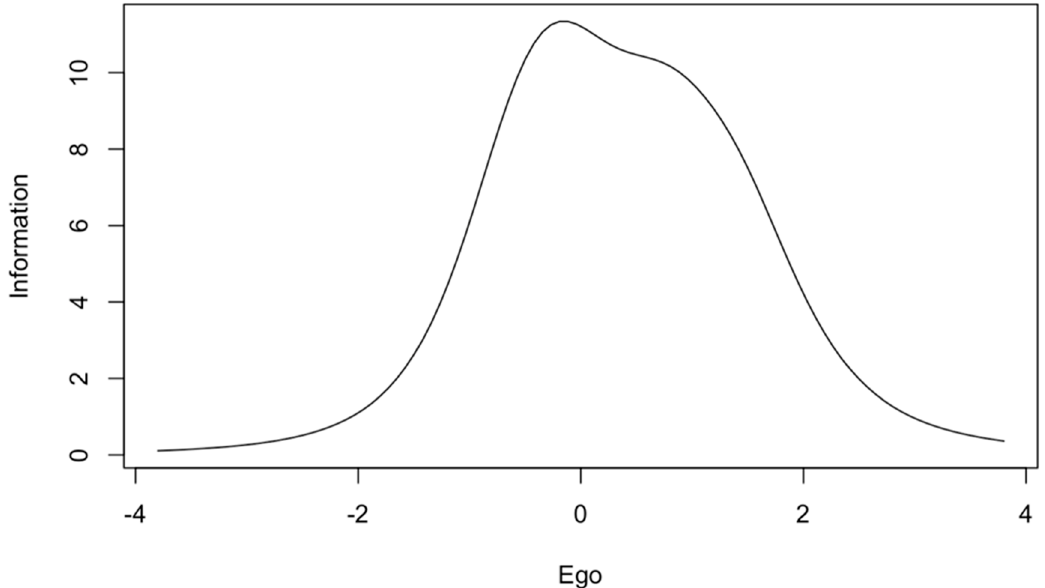
Figure 2. Information curve for the ego subscale of the GOEM scale.